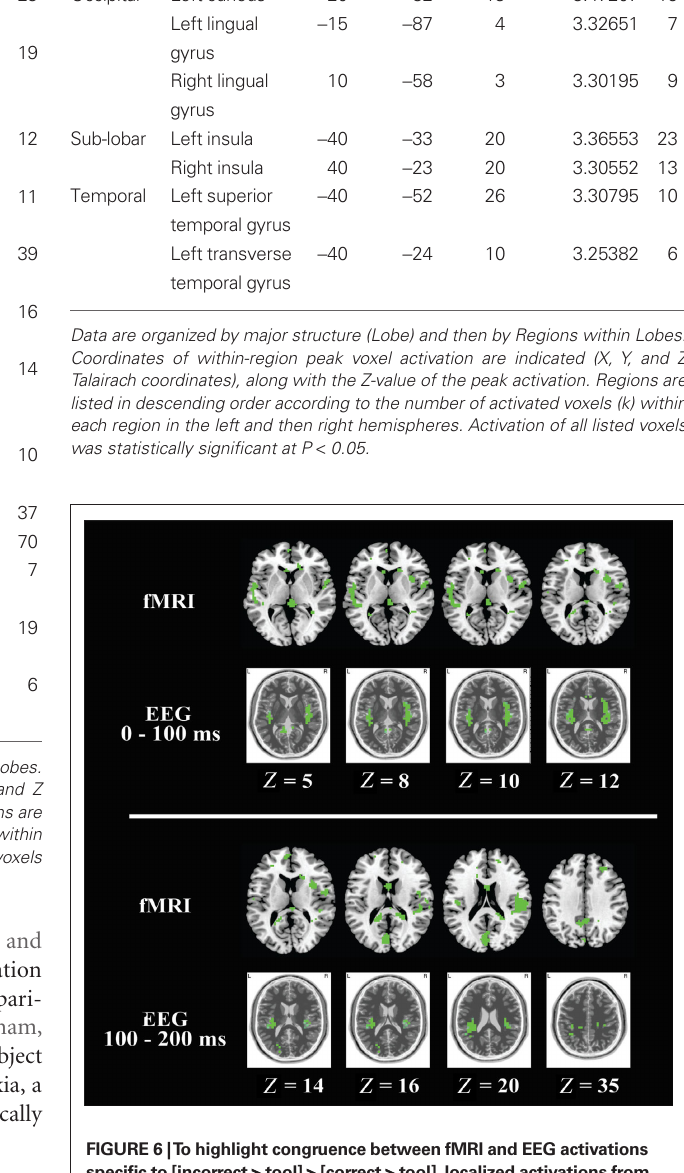
FIGuRE 6 | To highlight congruence between fMRI and EEG activations specific to [incorrect > tool] > [correct > tool], localized activations from both modalities are presented in slice image format at identical Talairach Z planes. fMRI activations ( P < 0.05) are shown along the top row and EEG FDR activations ( P < 0.05) are shown along the bottom row of the upper and lower panels. For each image, the nose is to the top of the image, and image left is anatomical left. The upper panel shows activations from 0 to 100 ms post image onset and the lower panel shows activations from 100 to 200 ms post image onset. Both fMRI and EEG slice images were taken at the same Talairach Z plane. Z coordinates are indicated below the EEG slices in the upper and lower